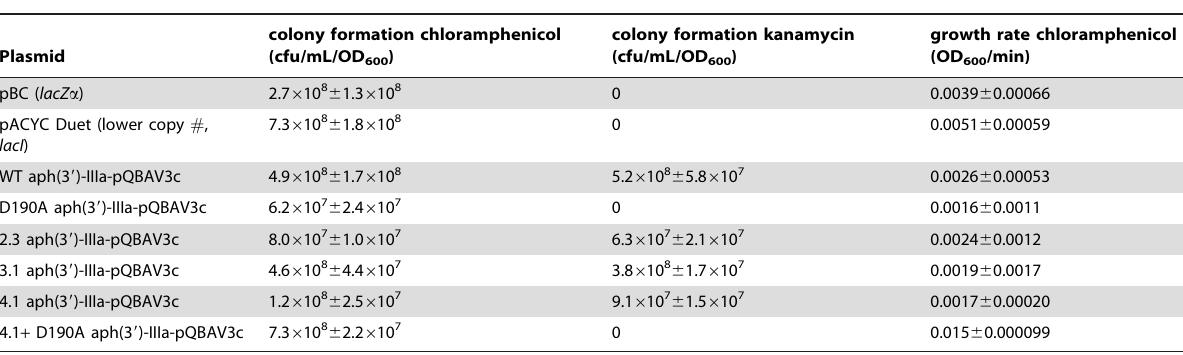
Table 5. Fitness of transformed isogenic Escherichia coli .